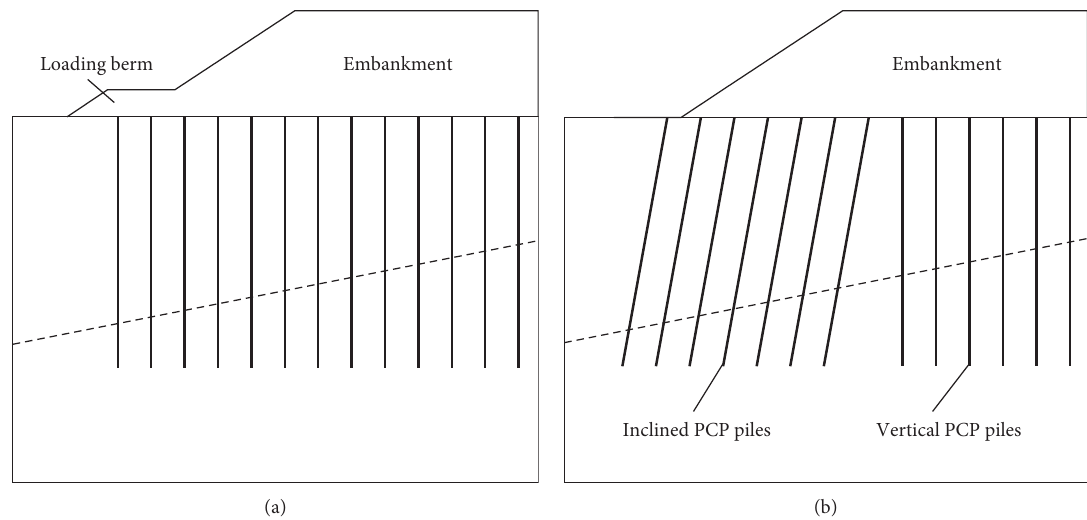
Figure 2: Models of pile-supported embankments. (a) Reinforcement model of the loading berm and (b) reinforcement model of inclined PCP